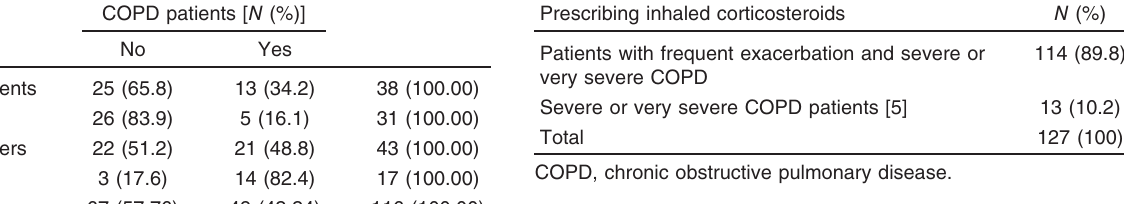
Table 21 Comparison between doctors ’ specialty and performing Table 23 Distribution of doctors according to prescribing spirometry to chronic obstructive pulmonary disease patients inhaled corticosteroids to chronic obstructive pulmonary disease Specialty Performing spirometry to COPD patients [ N (%)]